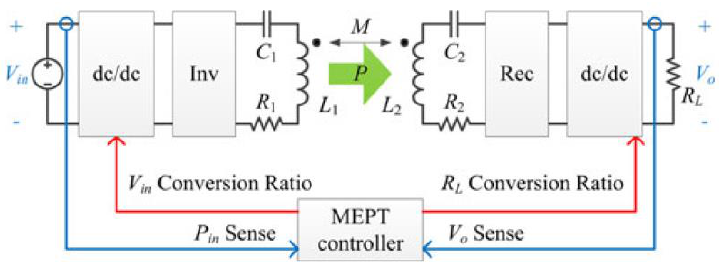
Figure 8. Closed-loop system structure of the MEPT control scheme proposed in [16].